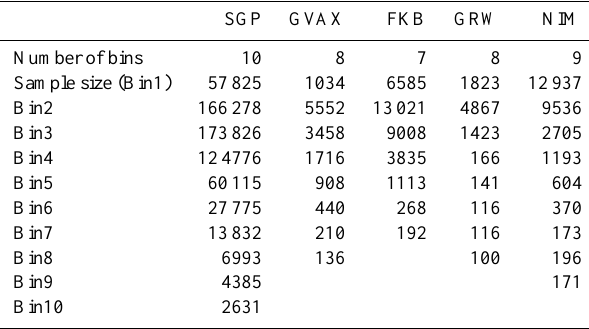
Table 3. Number of CCN bins and sample sizes for each bin in Figs. 2 and 4.